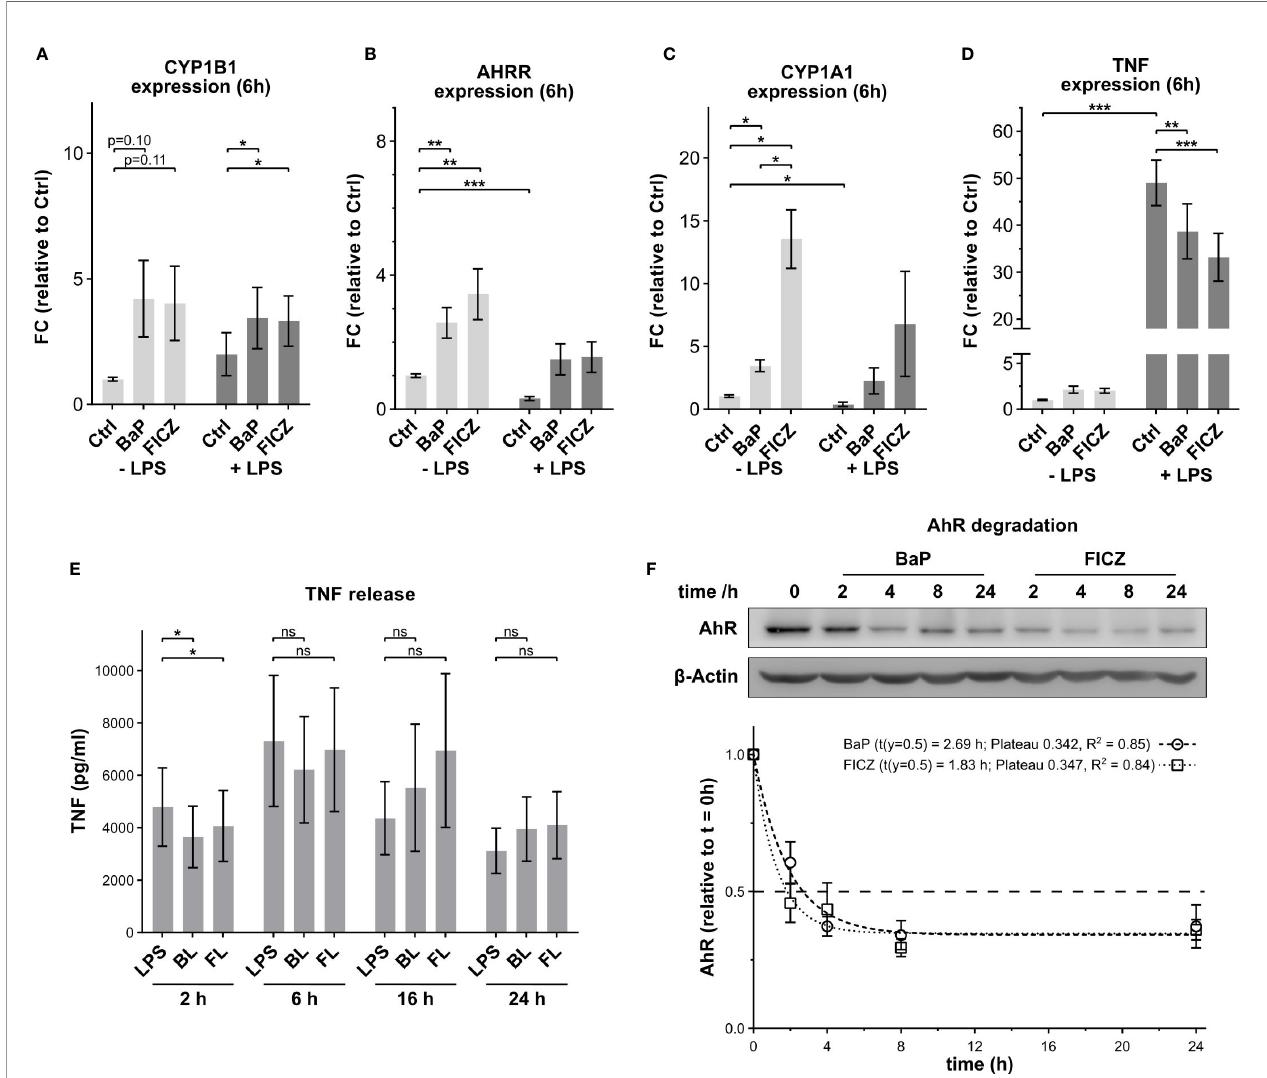
FIGURE 1 | Effect of AhR-ligands on target gene expression and TNF-release. The mRNA expression levels of the AhR-target genes CYP1B1 (A) , AHRR (B) , and CYP1A1 (C) were determined by qPCR after 6h stimulation with 2 µM BaP or 100 nM FICZ. (D) The TNF mRNA expression levels were determined by qPCR 6h post stimulation with 2 µM BaP or 100 nM FICZ in the absence and presence of 100 ng/ml LPS. Data were normalized to RPLP0, and the gene expression levels were calculated relative to the unstimulated control. Data are shown as mean ± SEM (n = 5). (E) TNF release in cell supernatant. TNF concentrations in the supernatants were measured by ELISA 2h, 6h, 16h, and 24h after treatment. Data are shown as mean ± SEM (n = 5). Signi fi cant changes were determined by two- sided, paired t-test (***p ≤ 0.001, **p ≤ 0.01, *p ≤ 0.05; ns, not signi fi cant). (F) The degradation of AhR in response to 2 µM BaP or 100 nM FICZ was determined by western blot. AhR signal intensities were normalized to b -Actin levels. Shown is one representative blot and normalized intensities relative to t = 0h ± SEM (n = 4). The degradation was analyzed as one phase decay by least squares fi